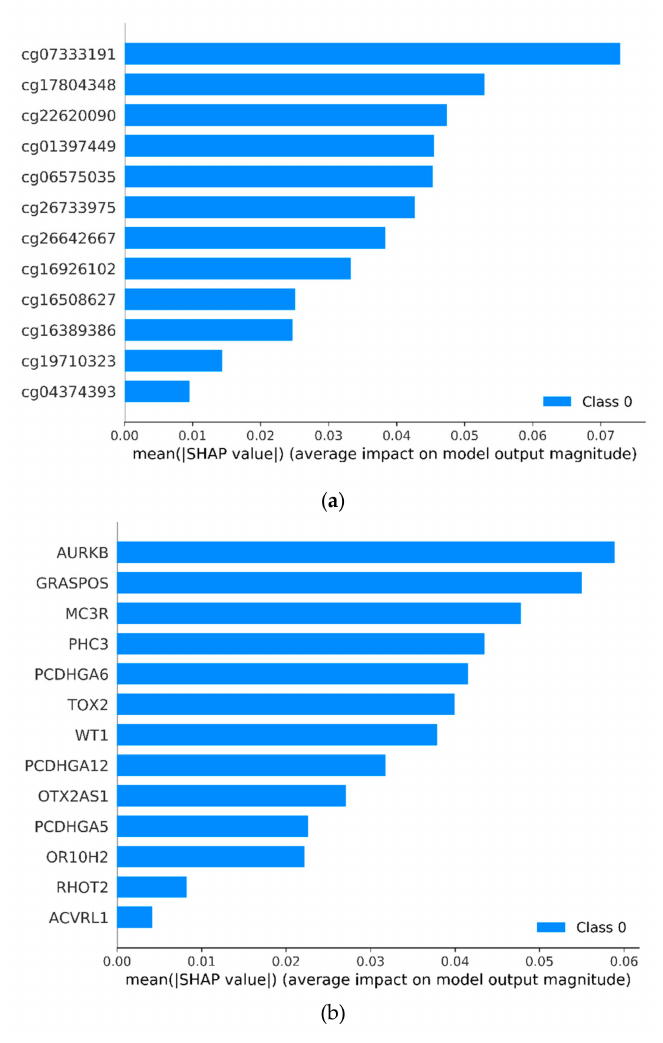
Figure 6. The distribution of average absolute SHAP value for all markers. ( a ) comes from 12 CpG markers and ( b ) comes from 13 promoter markers. SHAP: SHapley Additive